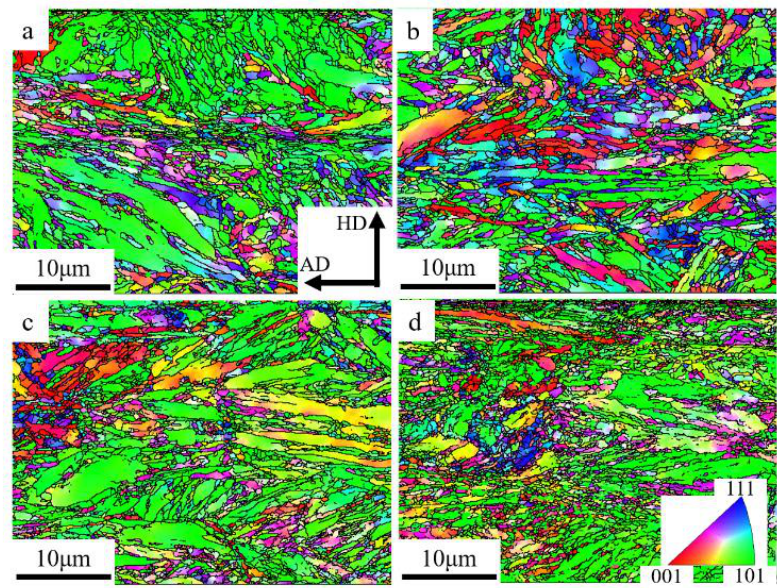
Figure 8. The IPFX maps of the forged tube with a reduction of 42.7%: ( a ) r = 11.0 mm; ( b ) r = 8.3 mm; ( c ) r = 5.6 mm; ( d ) r = 2.9 mm.